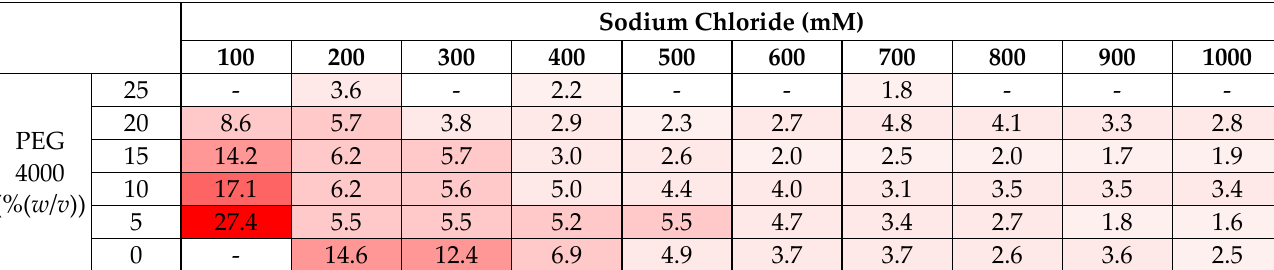
Table 3. Solubility of lysozyme in various concentrations of sodium chloride and PEG 4000. The solubility of lysozyme (mg/mL) was obtained by measuring the residual lysozyme concentration in the crystallization cell after crystal growth was completed.